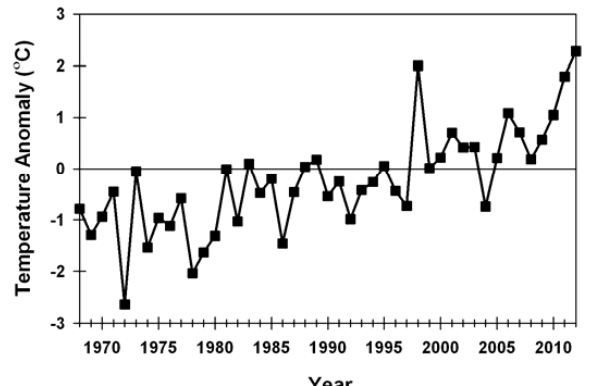
Figure 8. Time series of NCEP/NCAR mean June through September (JJAS) surface air Fig. 8. Time series of NCEP/NCAR mean June through September temperature (SAT) anomalies (  C) in the Canadian Arctic Archipelago, 1968-2012. Anomalies (JJAS) surface air temperature (SAT) anomalies ( ◦ C) in the Cana- calculated with respect to the 1981-2010 climatology. dian Arctic Archipelago, 1968–2012. Anomalies calculated with re- spect to the 1981–2010 climatology.